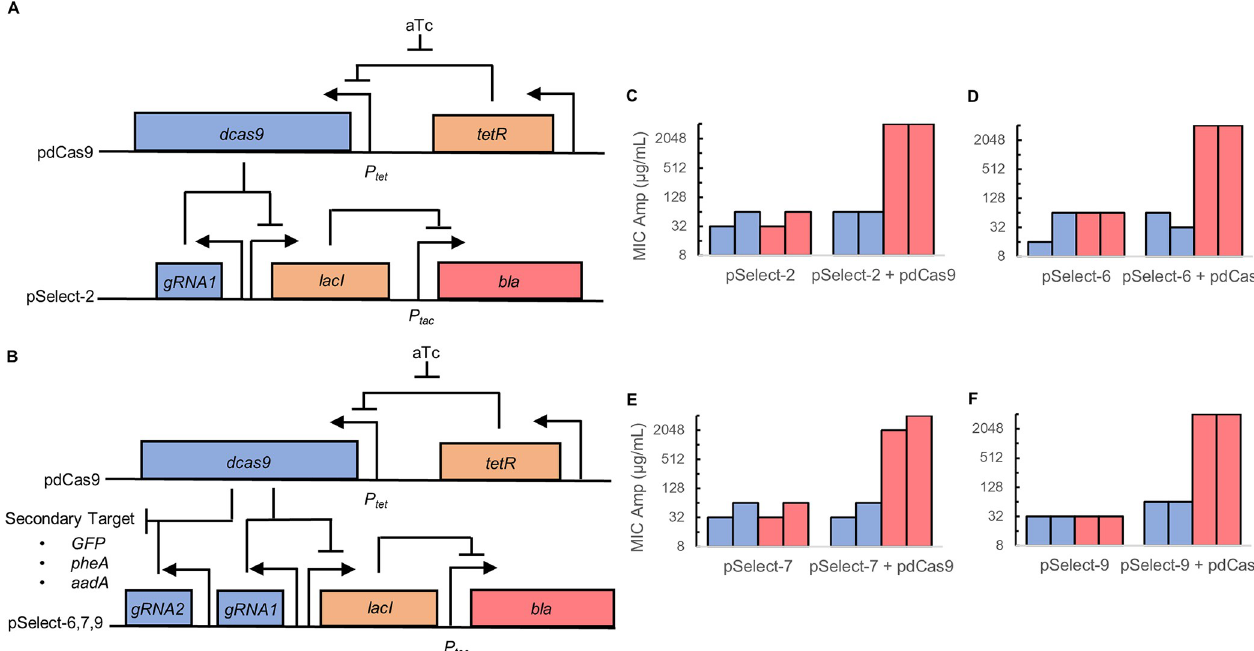
Fig 1. Positive selection system for dCas9 activity. (A) Schematic representation of the single gRNA positive selection circuit. LacI represses expression of β - lactamase ( bla ) and is repressed by dCas9 complexed with a LacI-targeting gRNA. Full plasmid maps provided as S1 Fig in S1 File. (B) Schematic representation of the dual gRNA selection circuit. An additional gRNA is incorporated into the selection plasmid, allowing dCas9 to target a second gene. (C-F) Replica minimum inhibitory concentration assays. Each experiment was performed in the absence (left bars) and presence (right bars) of the pdCas9 plasmid and in the absence (blue bars) and presence (red bars) of 2 nM aTc. Each assay was performed twice.